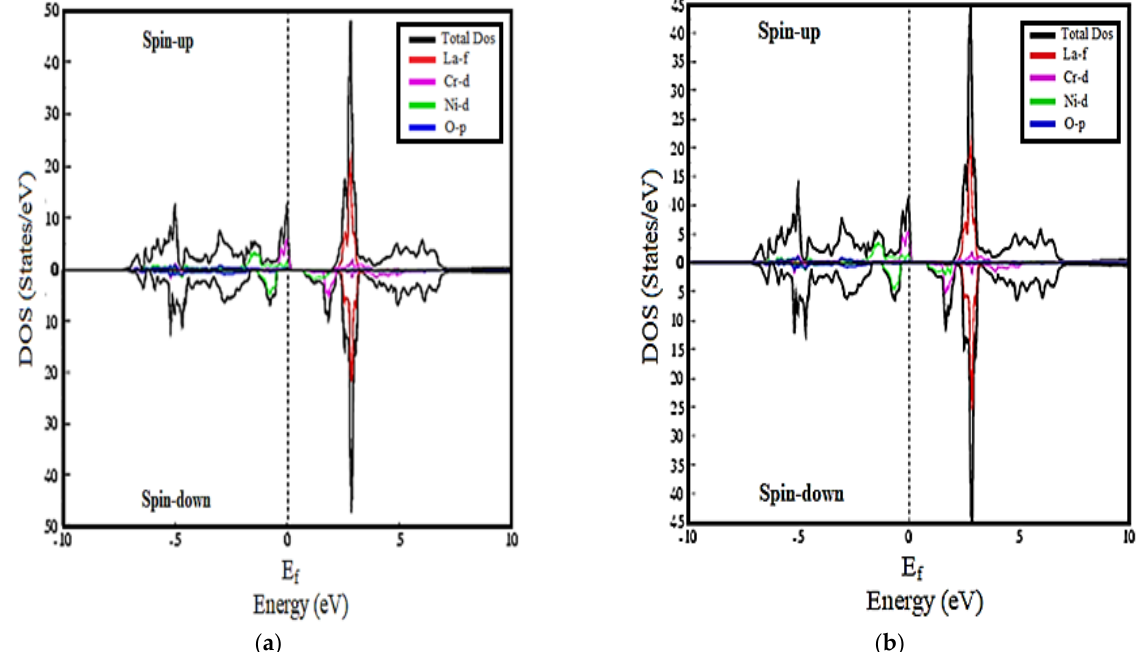
Figure 5. Density of states (DOS) of La 2 CrNiO 6 using ( a ) GGA and ( b ) GGA+U.